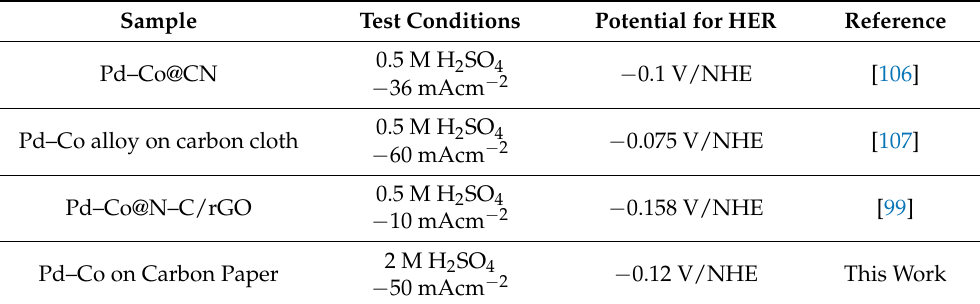
Figure 2. The galvanostatic test conducted at − 50 mAcm − 2 for 3 h in 2 M H 2 SO 4 aqueous solution at 25 ◦ C. ( a ) Pure Pd and Co deposits at different deposition current density for 3600 s. ( b ) Pd–Co alloys obtained from a dilute solution (about 17% in Pd) at different deposition current densities for 900 s. In Table 6 a comparison of our results with the reported performances in the literature relative to the Pd–Co-based electrodes is reported. This Table shows that our results align with the published data. Table 6. A comparison with the literature